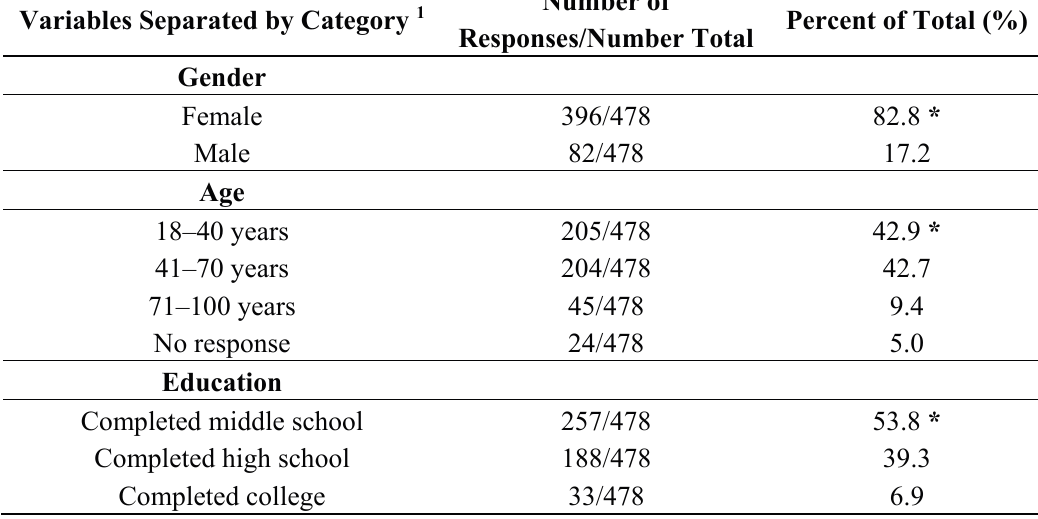
Table 1. Details of the social profile of respondents who live in areas near the Mossoró River, in the neighborhoods of Ilha de Santa Luzia, Alto da Conceição and Paredões in the city of Mossoró, Rio Grande do Norte, Brazil,